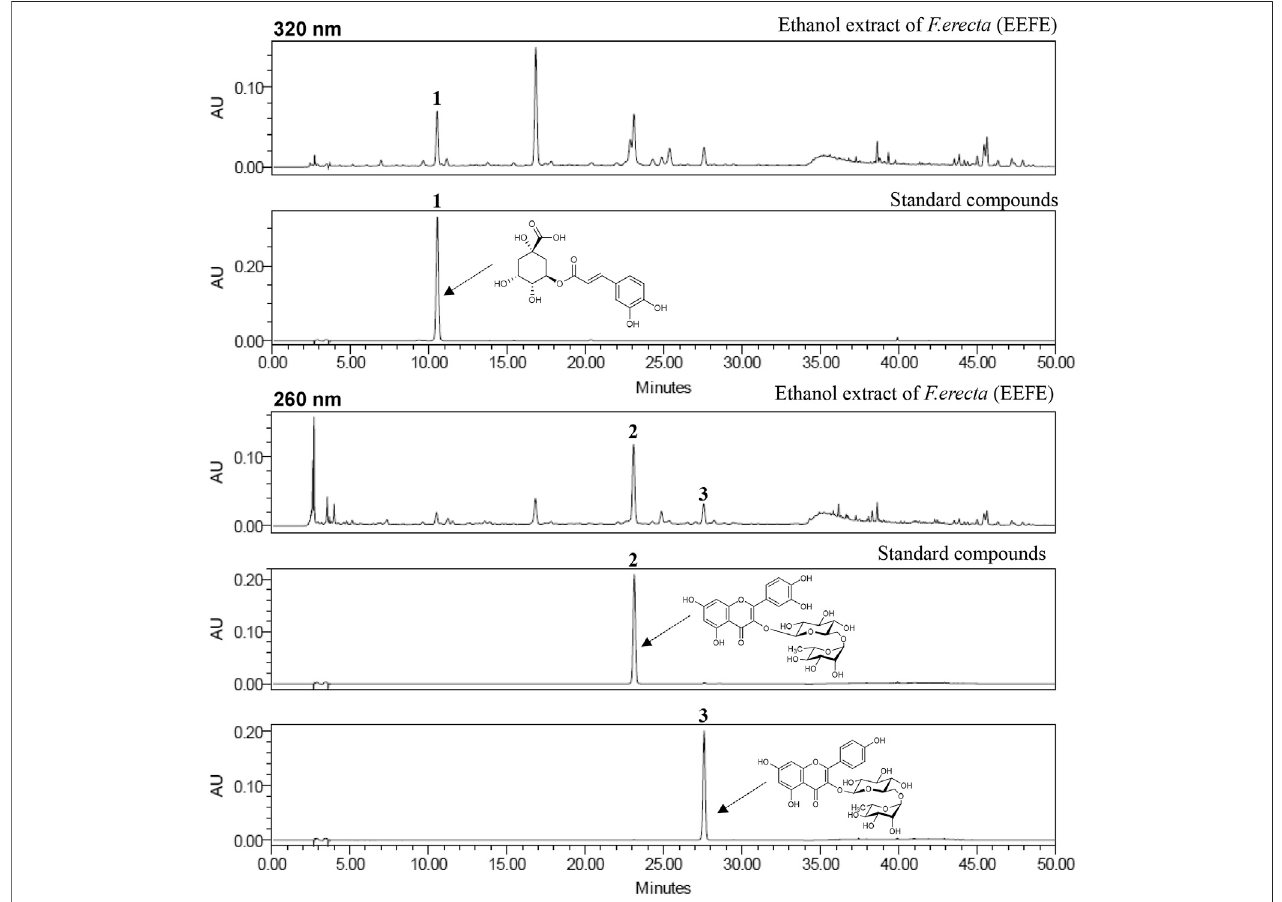
FIGURE 8 | HPLC chromatograms of EEFE and standard mixture at 260 and 320 nm chlorogenic acid (1), rutin (2), and keampferol-3-O-rutinoside (3).